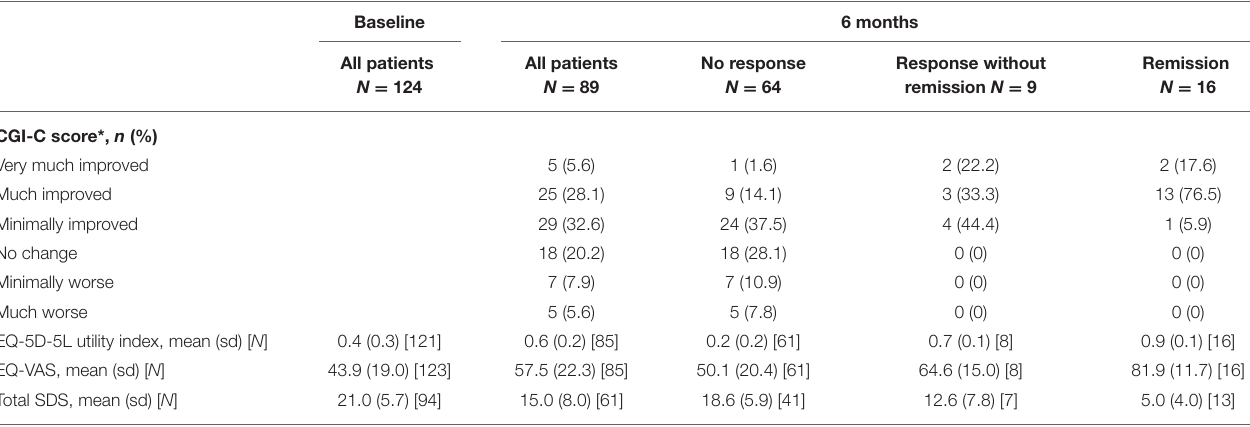
TABLE 2 | Change in depression severity at 6 months compared to the baseline visit (CGI-C score), and quality of life and disability at baseline and at 6 months in patients with treatment-resistant depression (TRD), overall and by clinical response at 6 months.